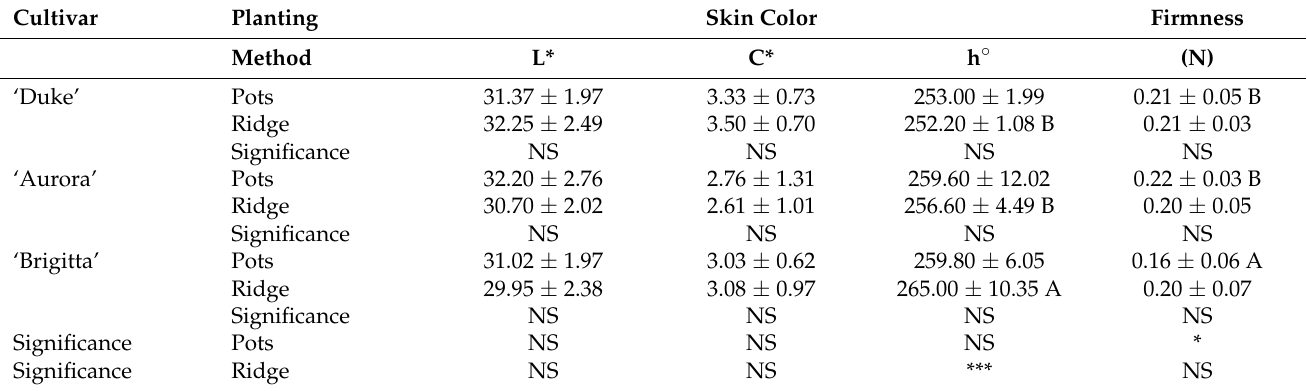
Table 1. Blueberry skin color and fruit firmness for blueberry ‘Duke’, ‘Aurora’, and ‘Brigitta’ fruit harvested from plants grown in pots and along the